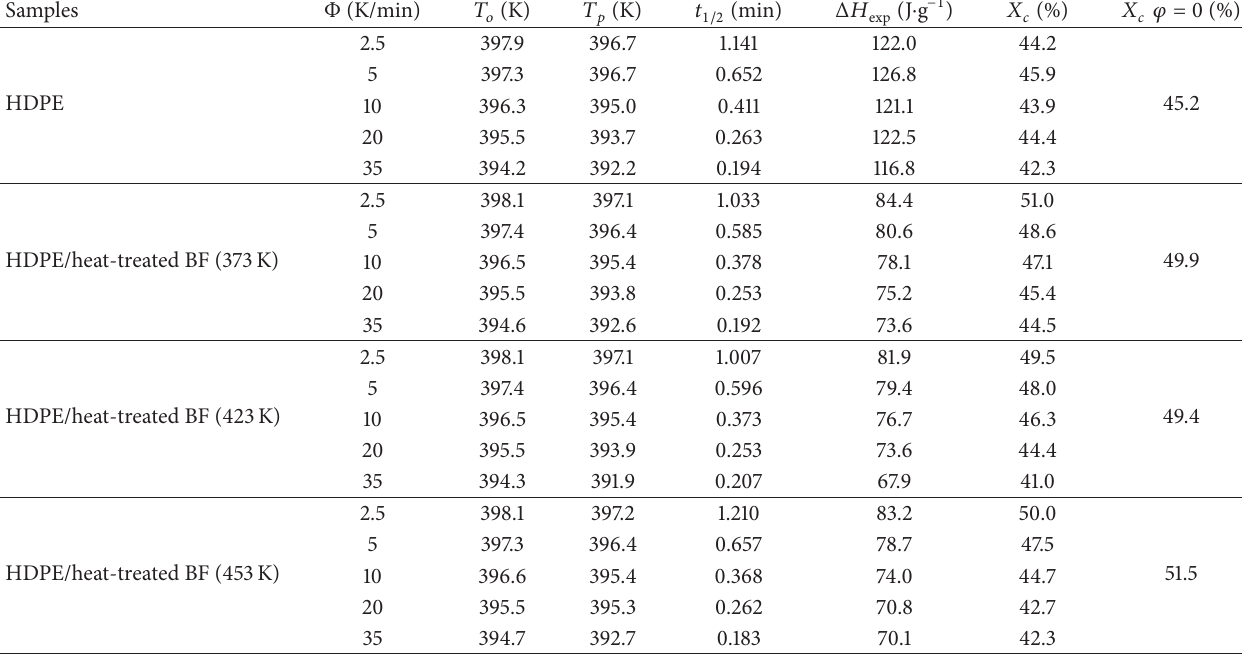
Table 1: Nonisothermal crystallization parameters of HDPE and its